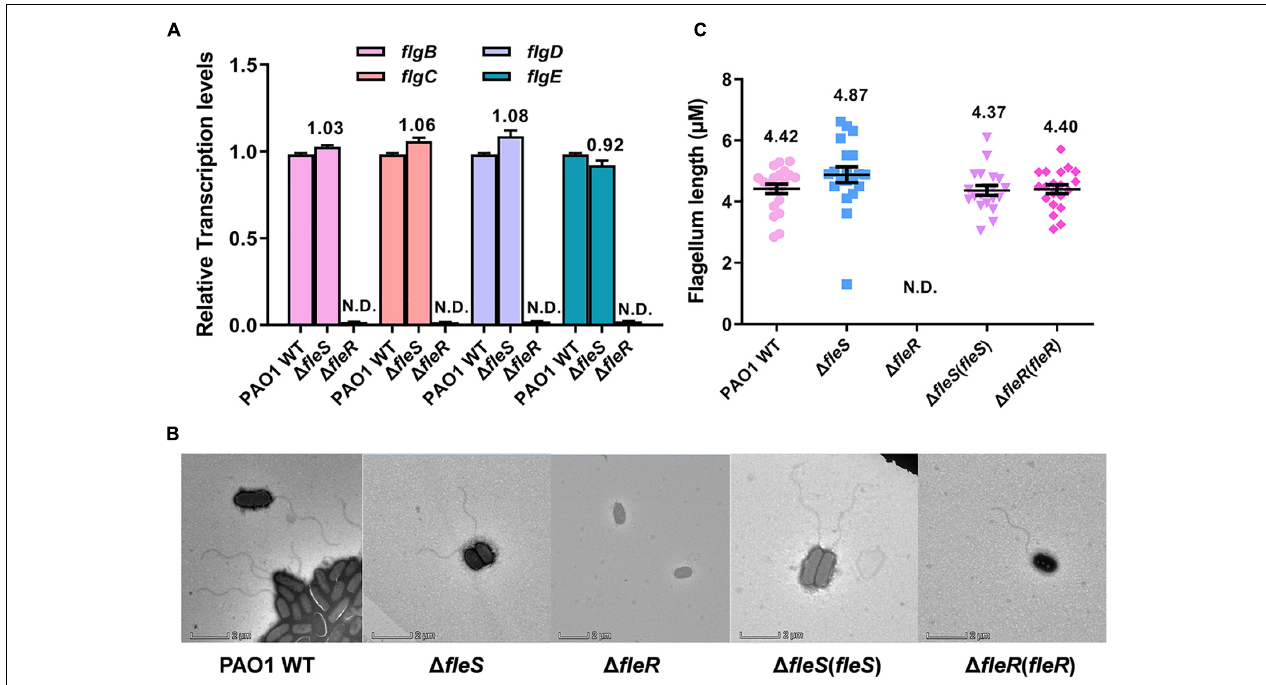
FIGURE 7 | FleR regulates flagellum biosynthesis independent of FleS. (A) Expression levels of flgB-E were examined in the PAO1 wild type (WT), the (cid:49) fleS and (cid:49) fleR mutants. N.D., not detected. (B) Observation of flagellum in the PAO1 wild type, the (cid:49) fleS and (cid:49) fleR mutants as well as their corresponding fleS and fleR complemented strains by TEM. A representative image of each strain is shown. (C) The average flagellum length measured from the stains in panel (B) . Twenty cells were selected for the measurement from each strain.